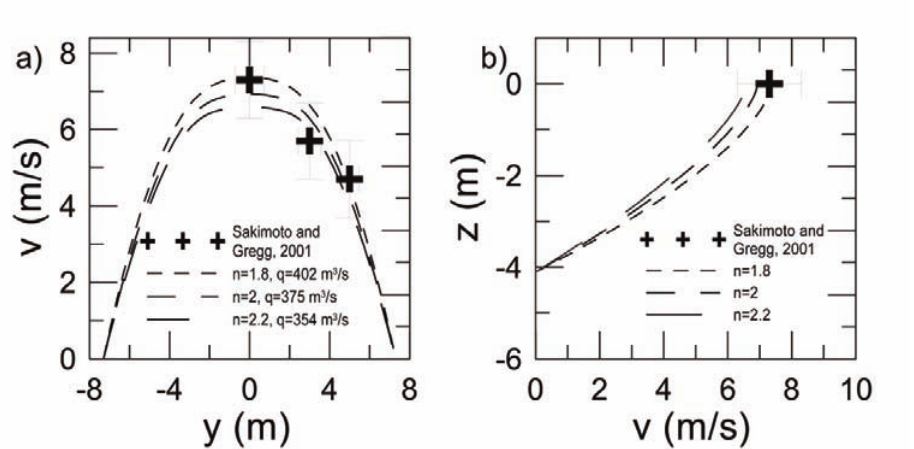
Figure 6. Matches between the measurements of the flow velocity (crosses) and the velocity profiles (lines) computed with a dilatant model ( n > 1) for the channel flow of April 2, 1984, Mauna Loa eruption. a) Horizontal profiles at z = 0. b) Vertical profiles at y = 0. The parameters of the channel are: a = 14.6 m, h = 4.1 m, a = 8˚; the parameters of the lava are: t = 1200 kg m −3 and k = 850–1400 Pa s n (data from Sakimoto and Gregg [2001]; viscosity from Harris and Allen III